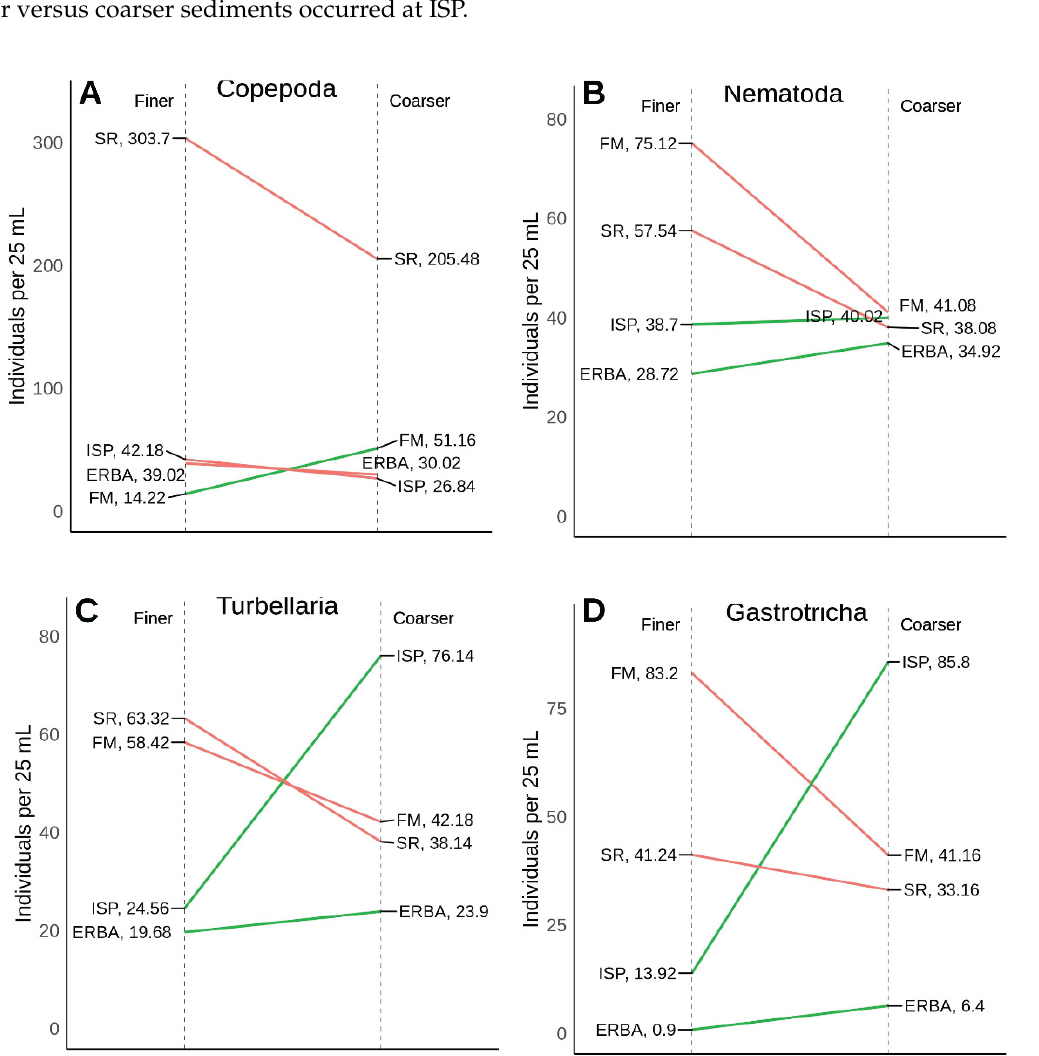
Figure 10. Univariate ( A – D ) comparisons of mean taxon abundances collected in low intertidal, surface finer and coarser sediment samples from four different beaches in 2006. Finer ( E ) and coarser ( F ) multivariate results are disaggregated to ease visual comparison; non-metric scales serve to ease visual estimation of dissimilarity distances but are not associated with any specific units.